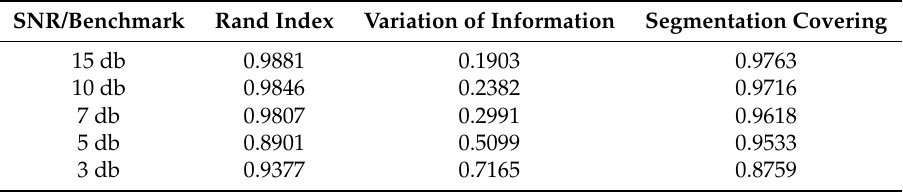
Figure 8. Each row (( a ) to ( c )) shows the input image, the minimization output and the thresholded (rounded) output (from left to right) for different levels of additive noise: ( a ) noise = 15 dB, >99% classified correctly, ( b ) noise = 10 dB, >98% classified correctly, ( c ) noise = 5 dB, >95% classified correctly. Table 1. Evaluation of the performance for various levels of SNR (comparison to ground truth).